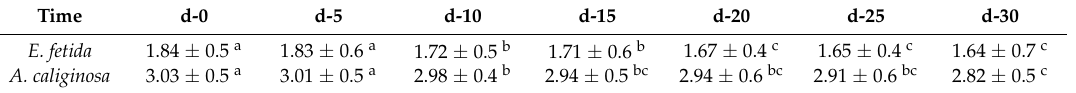
Table 1. Effect of Cd LC50 values on earthworm body weight loss with the respect to the time.